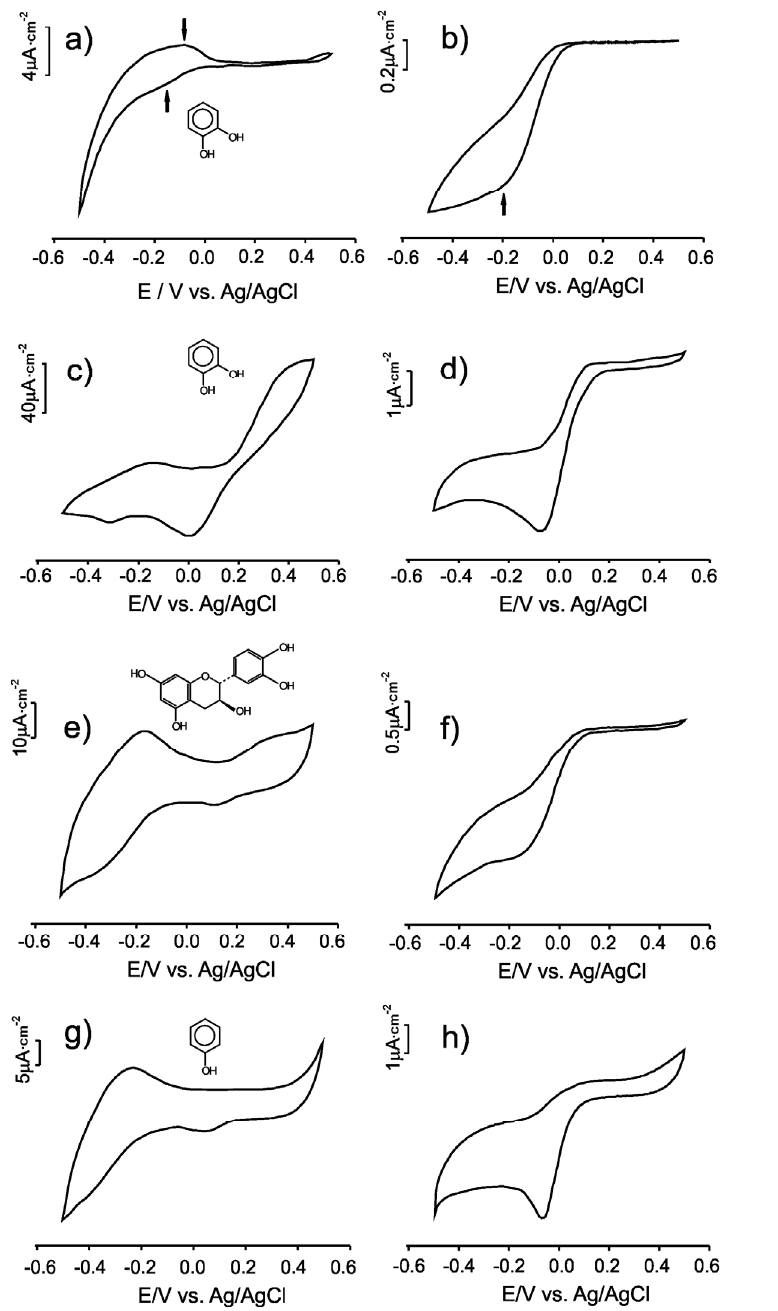
Figure 1. Cyclic voltammograms of Langmuir-Blodgett (LB) and carbon paste